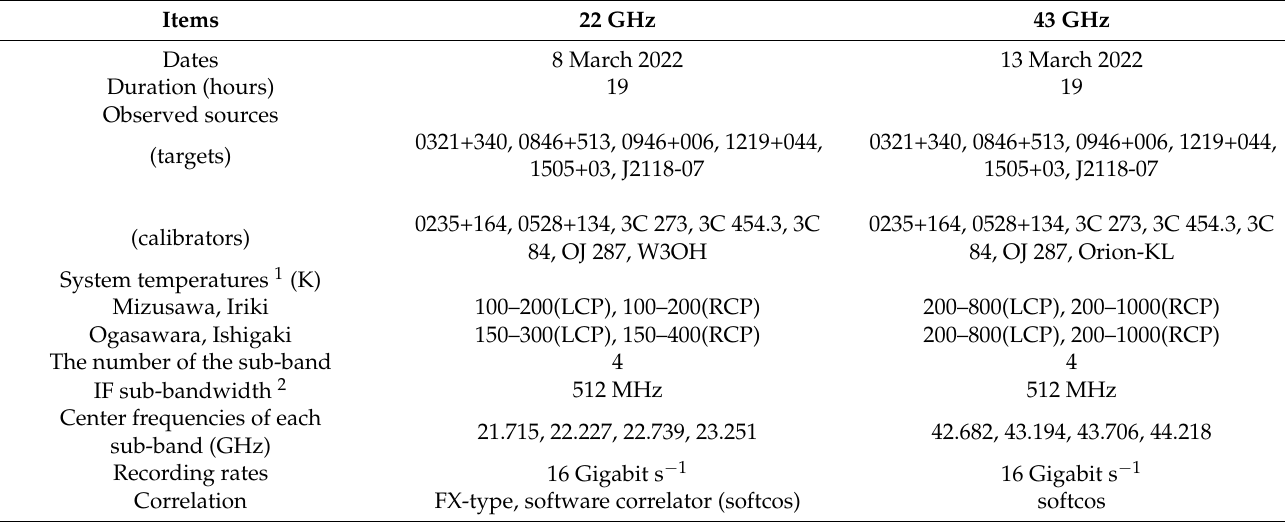
Table 2. Summary of